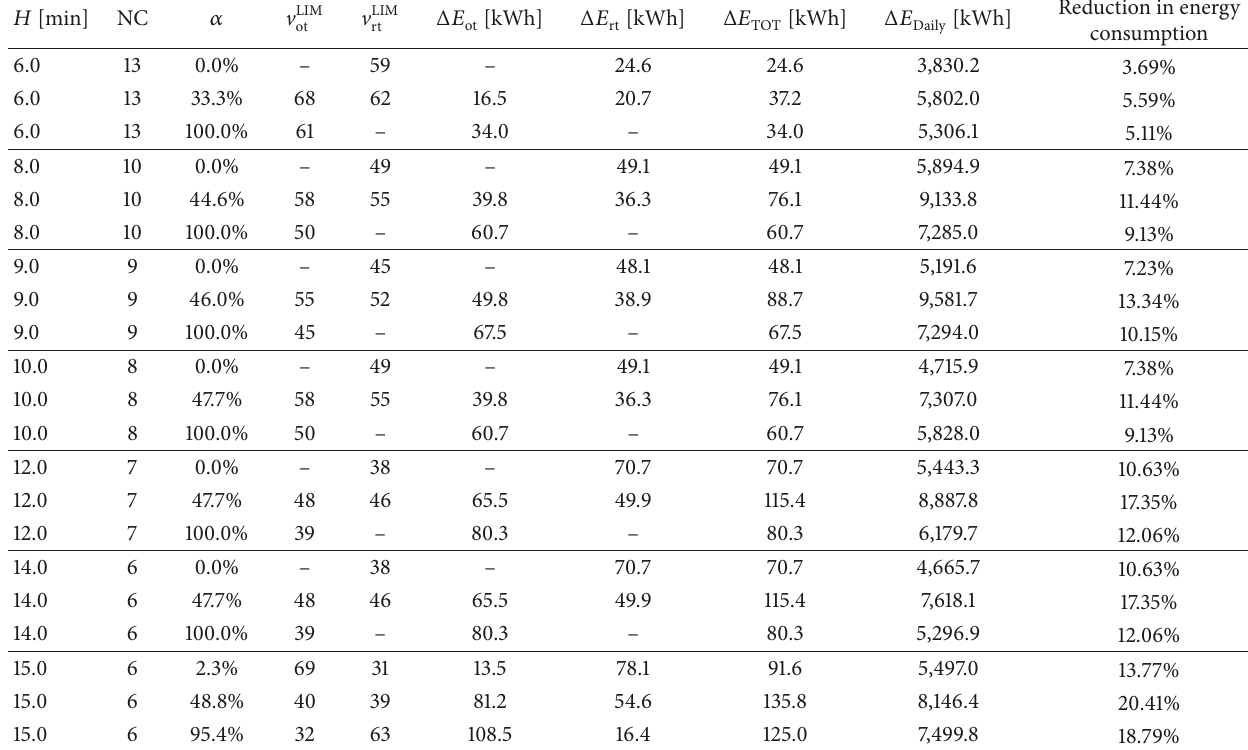
Table 8: Energy variations in the case of the 99th